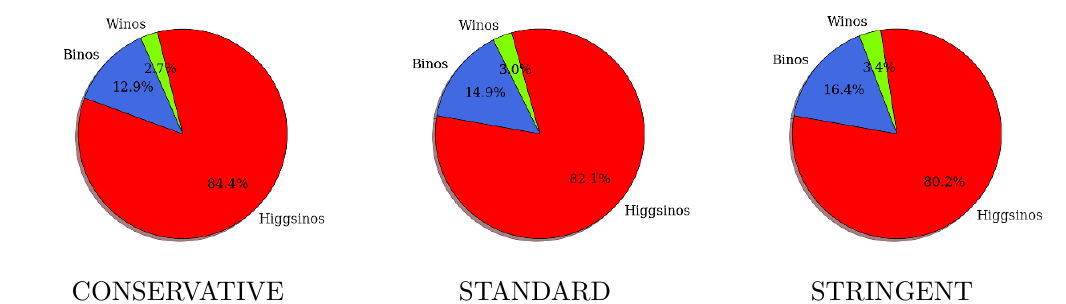
Figure 24 . Fractions of neutralino 1 types in our scan after imposing all the constraints, including also the lower relic density limit.